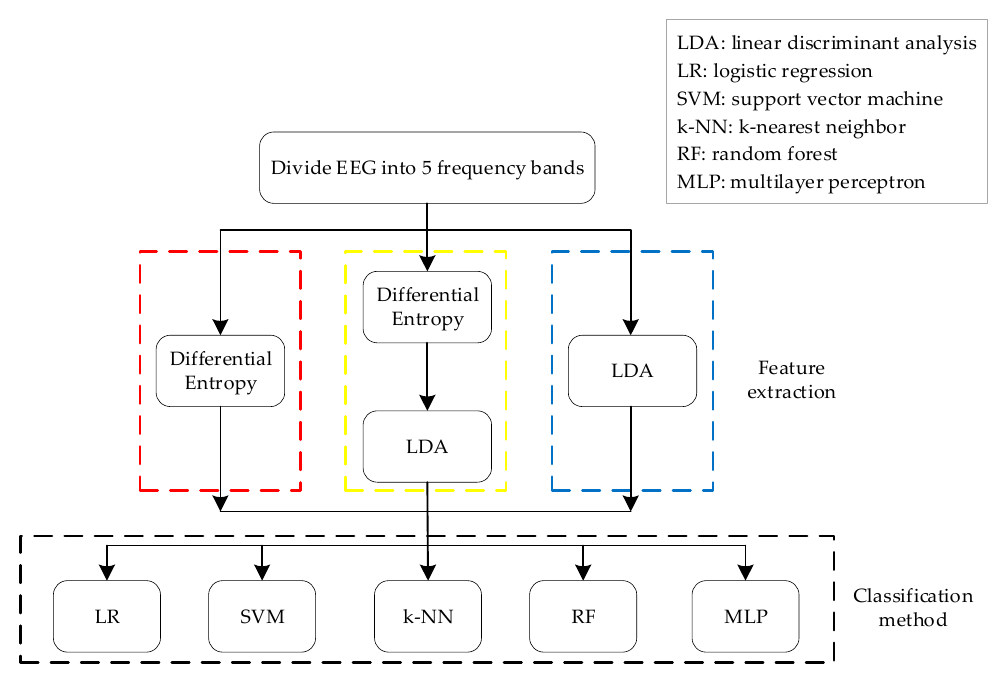
Figure 1. Flow chart of algorithm architecture.